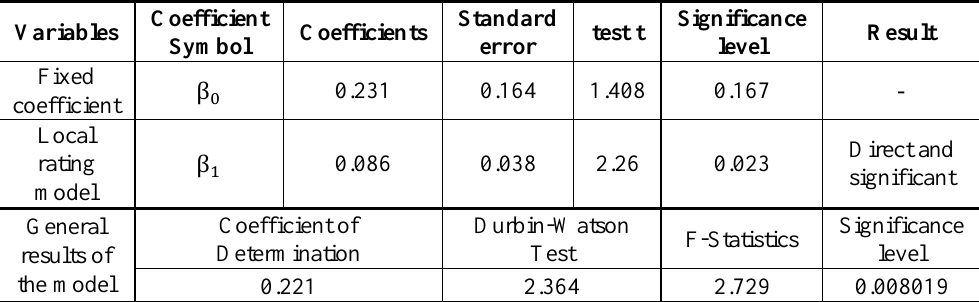
Table 9. Results of regression model fitting and coefficient